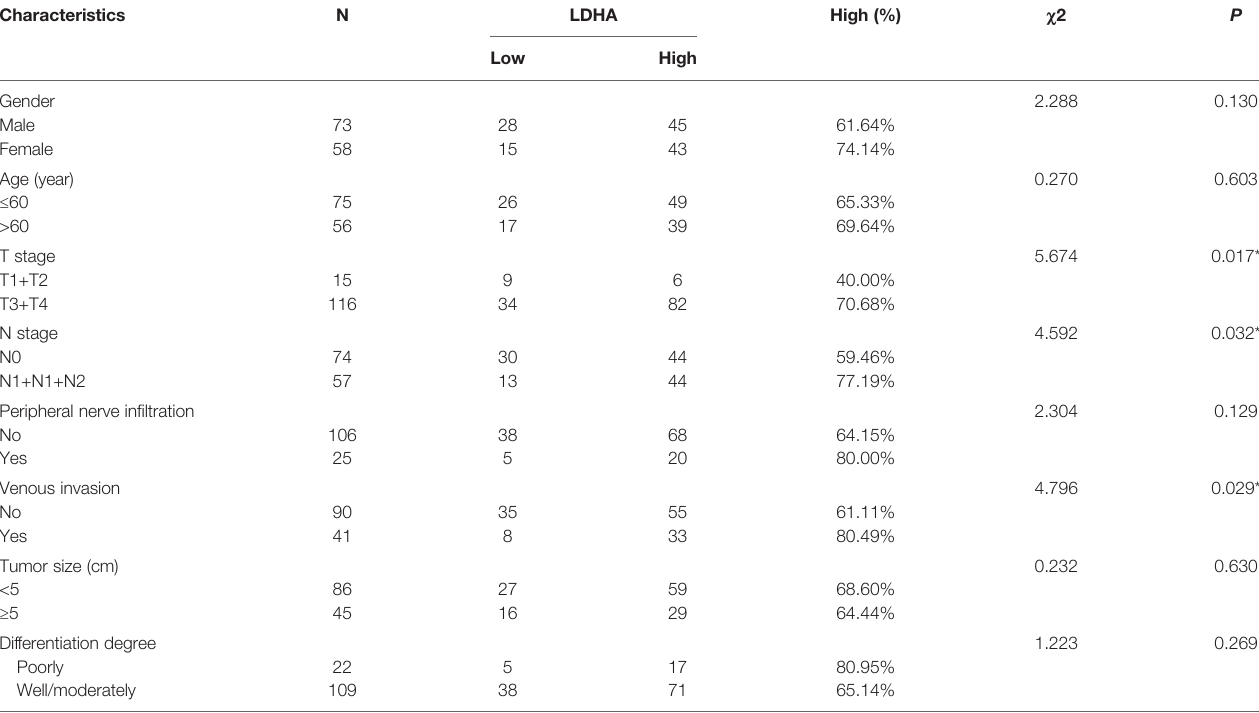
TABLE 2 | Association between the expression of LDHA and clinicopathological parameters of COAD (n = 131). Characteristics